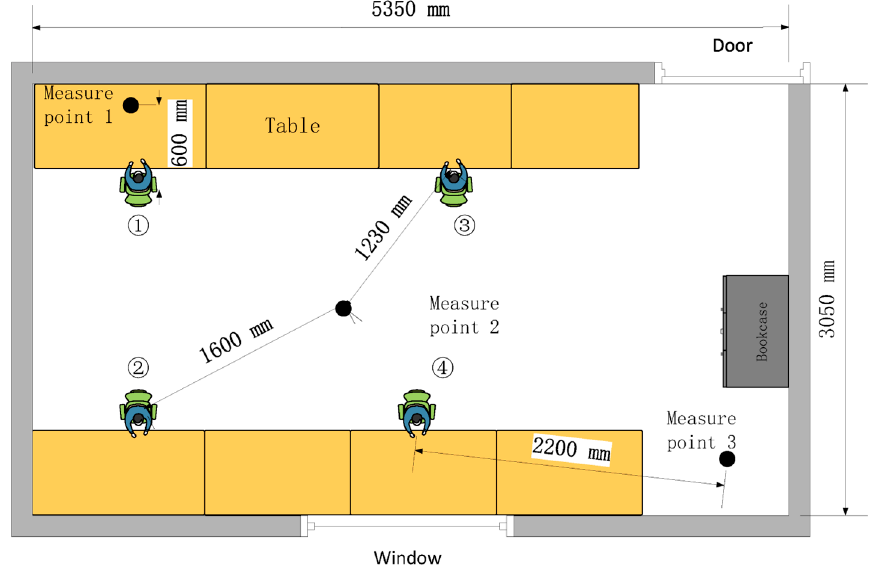
Figure 2. Layout of the experimental room. The black dots indicate measure points. The numbers ① – ④ mark the staff position. Table 4. The sensor Parameters.